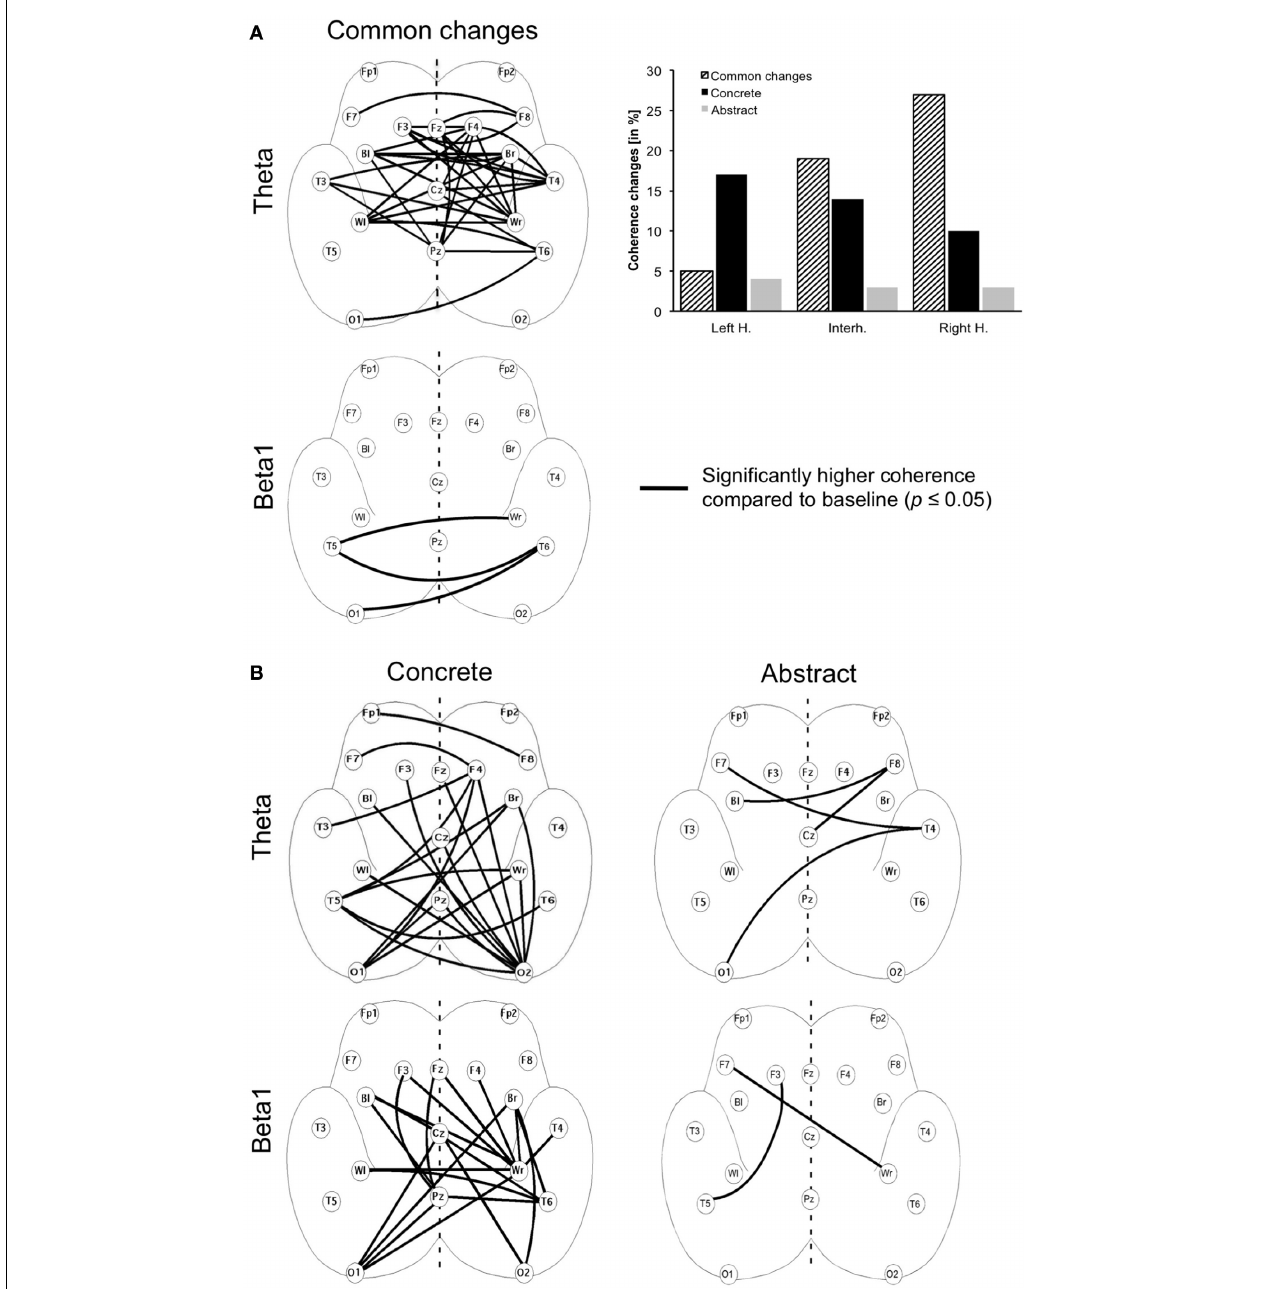
FIGURE 4 | Long-range coherence changes in the interval 2 (sentence without final noun) compared to the pre-sentence baseline (interval 1). Error probabilities ( p = 0 . 05) are mapped as lines on schematic drawings of the unfolded brain hemispheres. (A) Left panel: coherence changes, which occur as well for concrete as for abstract sentences (common changes) for theta and beta1. (A) Right panel: